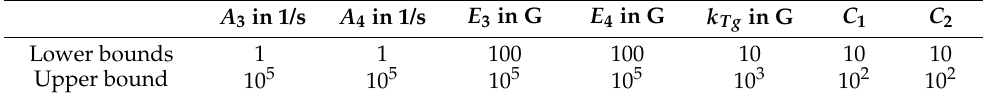
Table 2. Bounds used for parameter fitting in the least square error